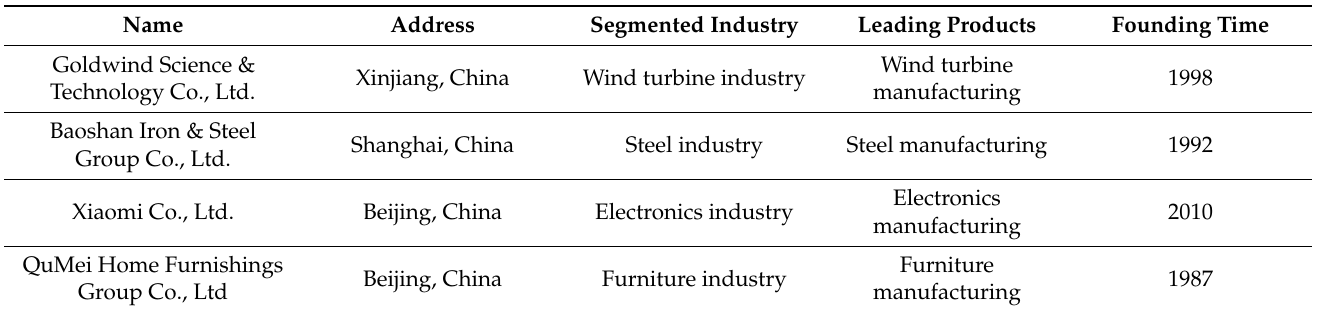
Table 1. Information on case